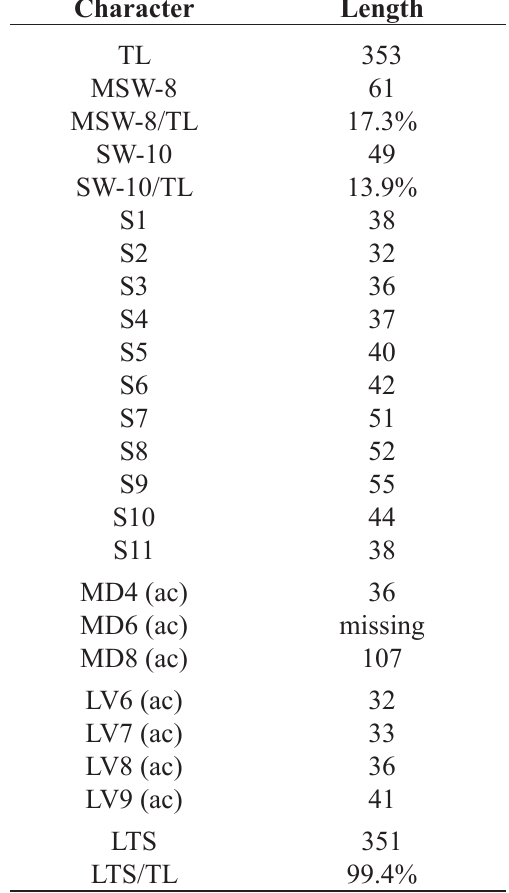
Table 2. Measurements from light microscopy for male holotype of Echinoderes anniae sp. nov. (in µm). Abbreviations: (ac) = acicular spine; LTS = lateral terminal spine; LV = lateroventral; MD, middorsal; MSW-8 = maximum sternal width, measured on segment 8 in this species; S = segment lengths; SW- 10 = standard width, always measured on segment 10; TL = trunk